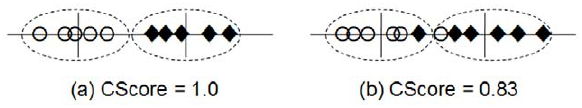
Figure 2. CScores of two features. Fig. 2(b) has two mis-clustered samples whereas Fig. 2(a) has clearly clustered